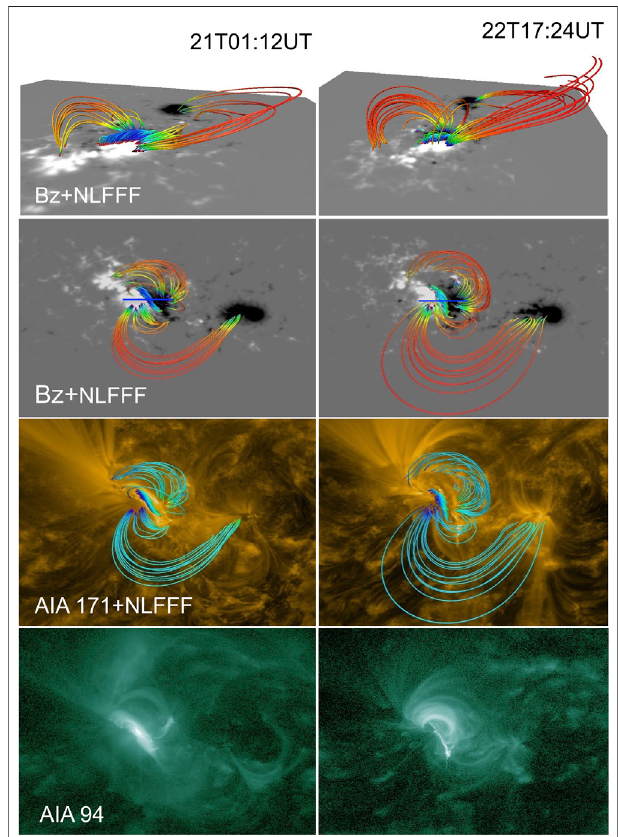
FIGURE 5 | Pre-eruptive magnetic structure modeled by NLFFF in the AR12371 fortheCME2 and CME3events. First row: Perspectiveviewofthe fi eld-linerendering.Bottomimageisphotosphericmagnetogram( B z ).Twisted structure along the PIL is overlaid by the less sheared fi eld lines Second row: fi eld lines plotted on top of the photospheric magnetogram ( B z ). The global structure is a sigmoid with two opposite-J-shaped sections and an inner core of highly twisted fi eld. Horizontal blue lines indicate the location of the slice plane for QSL analysis. Third row: same fi eld lines on AIA 171 Å images, Fourthrow: AIA94 Åimagesatthesametime.Hotplasmaemission is mainly co-spatial with the strongly sheared core along the PIL. To a good approximation, the modeled structure resembles the coronal plasma loops in the EUV images. Field lines are color coded (blue (red): 1,200 (2)G) with the horizontal fi eld strength in height in fi rst and second